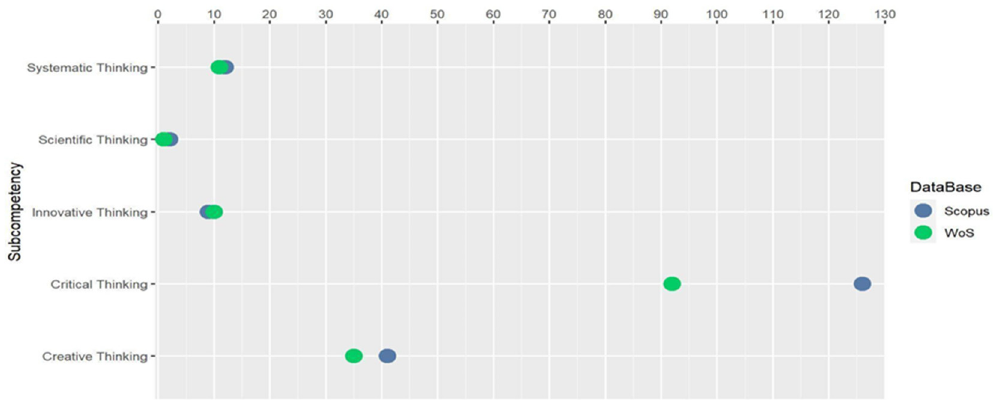
Figure 3. Managerial decision-making in business correlated with sub-competency of complex thinking: Search results in Scopus and Web of Science (WoS). Source: Created by the authors.